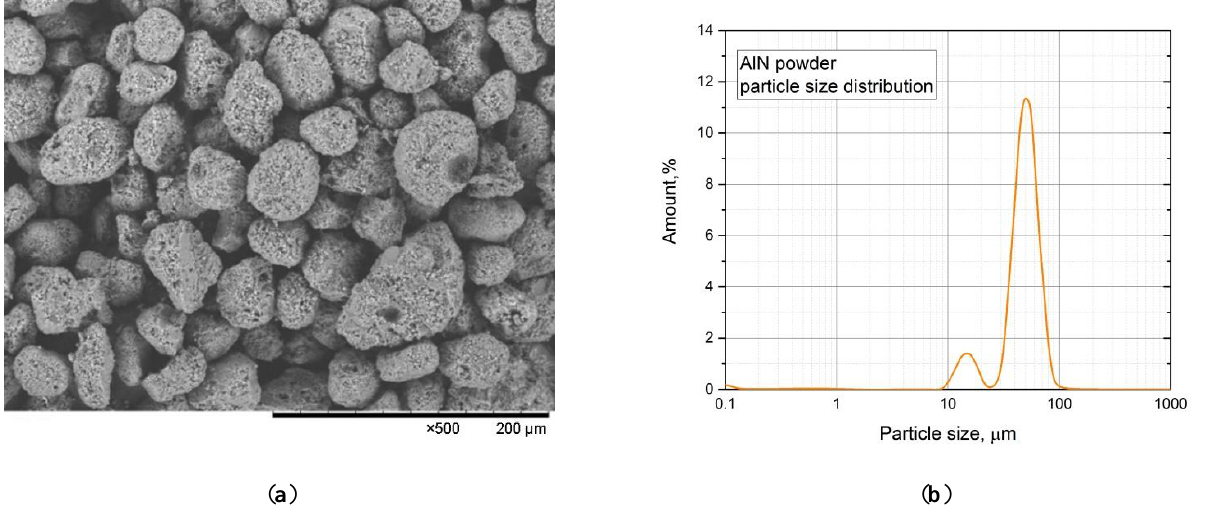
Figure 1. SEM image of morphology of the obtained AlN powder after sieving ( a ) and particle size distribution ( b ).